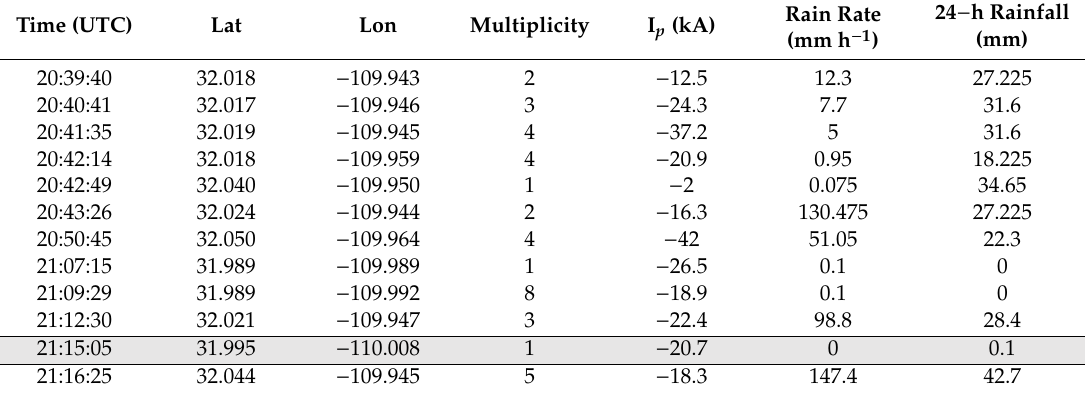
Table 3. CG flashes occurring the same day as the Lizard Fire initiation and their corresponding precipitation measurements, with the FS flash highlighted.